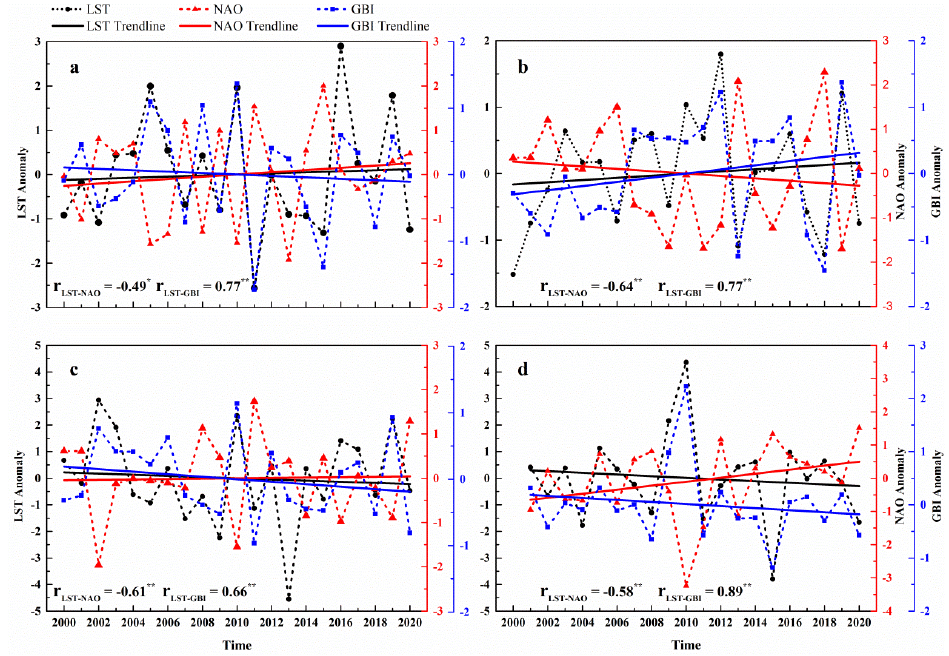
Figure 12. The GrIS LST, NAO and GBI anomaly time series, ( a ) MAM; ( b ) JJA; ( c ) SON; ( d ) DJF; * and ** Indicates a confidence level of 0.05 and 0.01